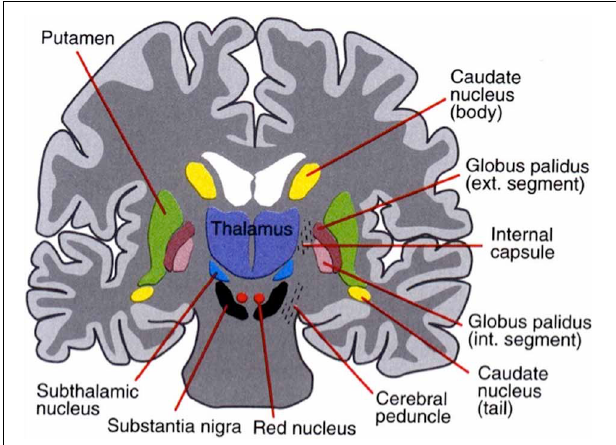
FIGURE 1 | The basal ganglia that clinically includes sub-thalamic nucleus and substantia nigra whose component structures are highly interconnected. The striatum is associated with input signal and output associated with the globus pallidus and substantia